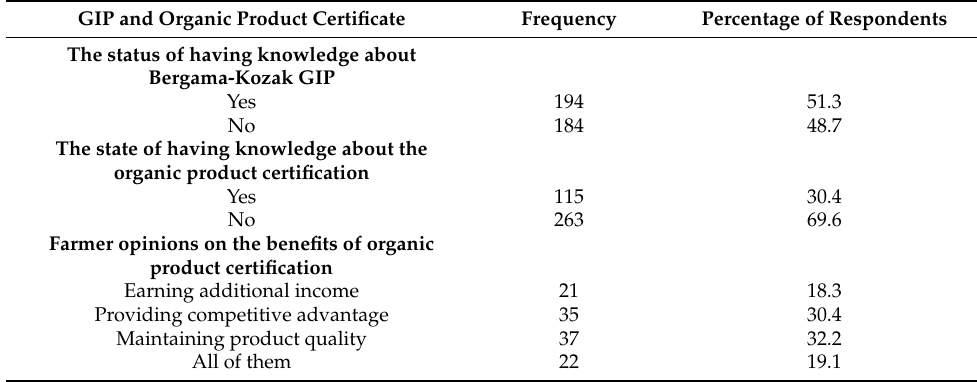
Table 10. Farmers’ opinions on GIP and organic product